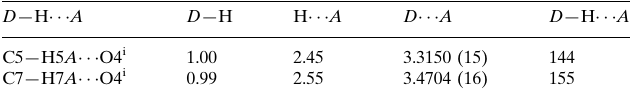
Hydrogen-bond geometry (A˚ , (cid:4)